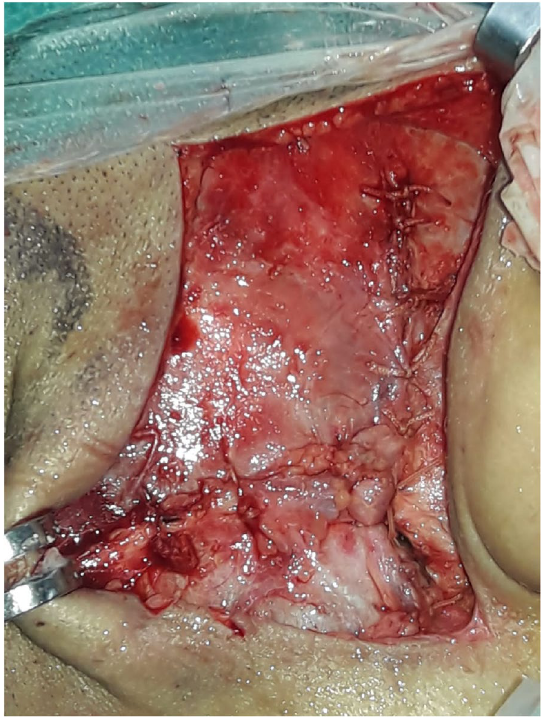
Table 1 Distribution of numbers, gender, side, implant, and electrode used through the study period Year Total number of cases had recess/tunnel technique fixation